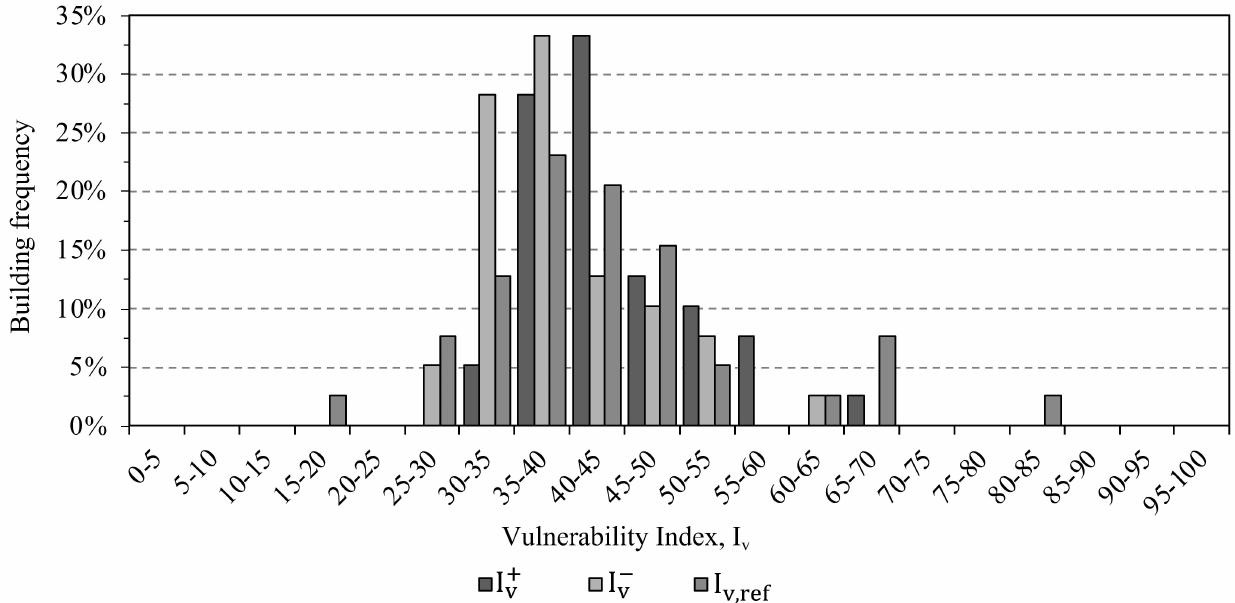
Figure 6. Vulnerability index obtained from I v,ref , I + v , and I − v , showing the normality of distribution. It is worth noticing that the extreme assessments (i.e., I + than the I v,ref values. The average reference value I v is equal to 42.88, and therefore, it fits well in the calculated range of 39.15–44.15. The standard deviation value obtained herein is quite different from the reference one, 7.43 and 12.74,